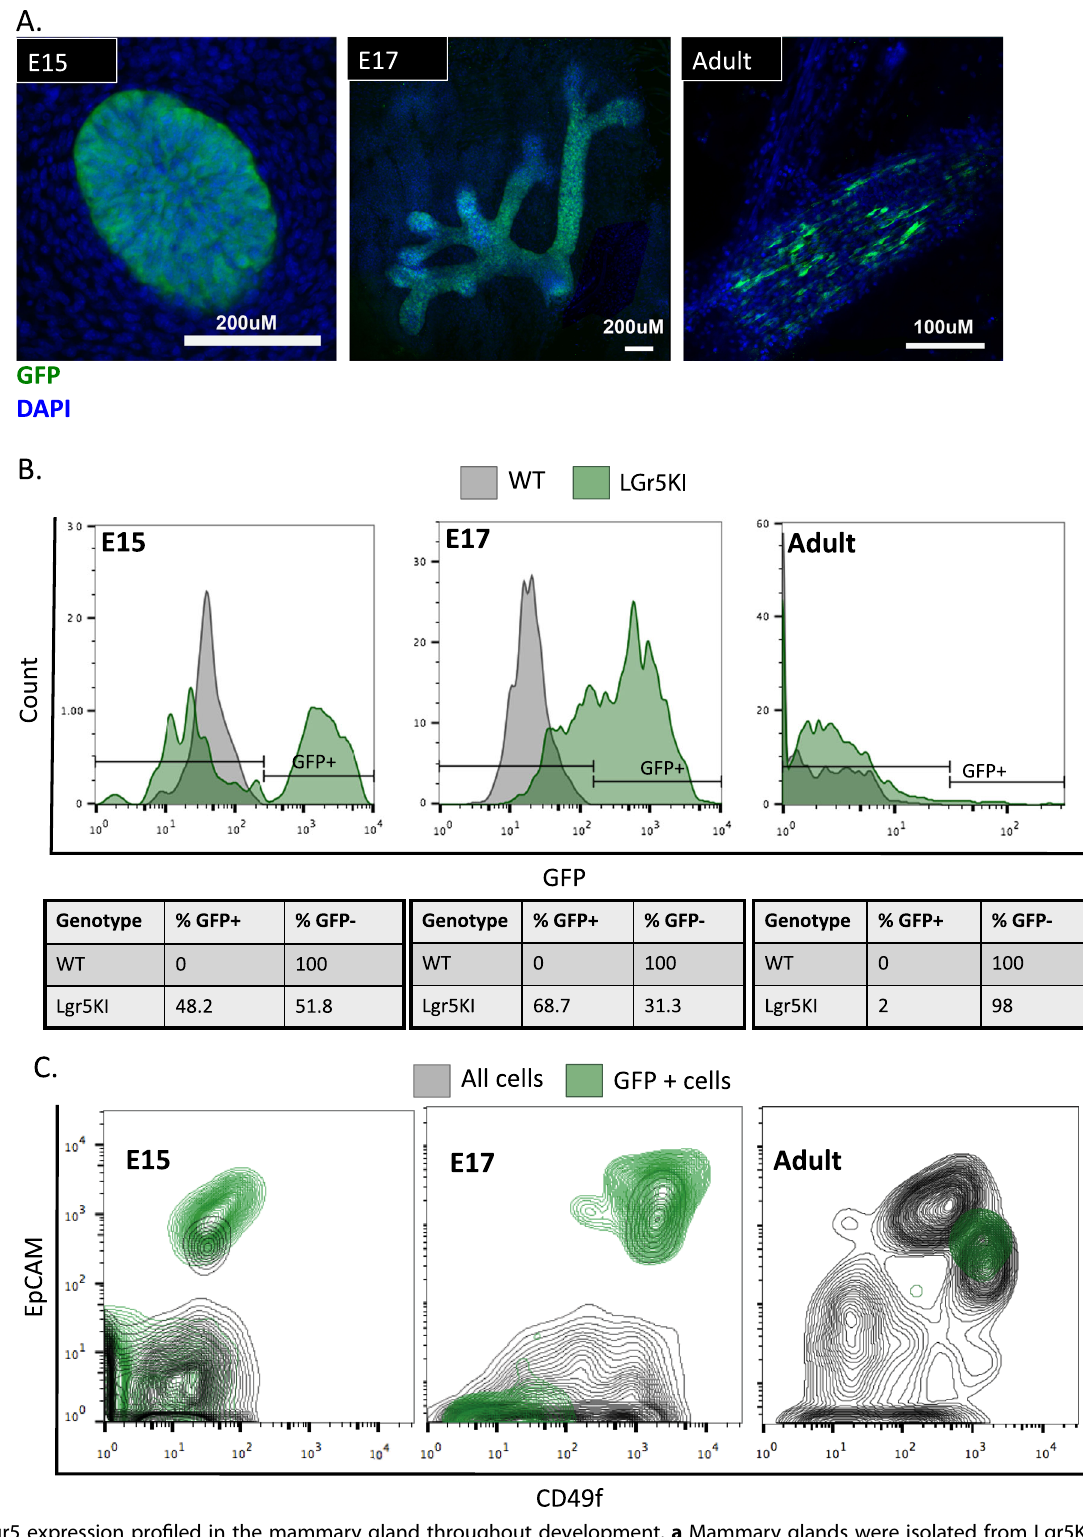
npj Breast Cancer (2017) 16 Published in partnership with the Breast Cancer Research